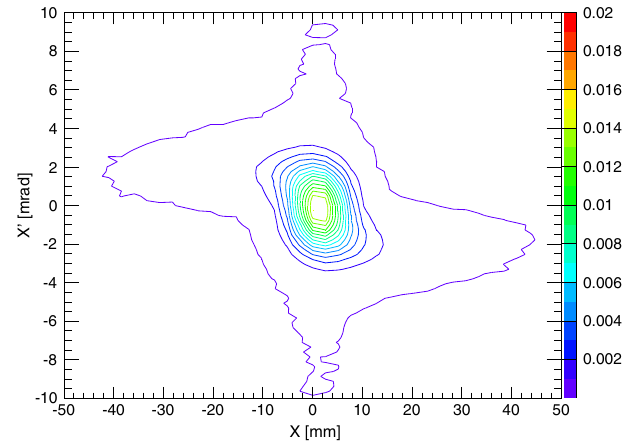
FIG. 20. Contour plot of transverse phase space distribution in the horizontal direction for beam scattered from the muon production